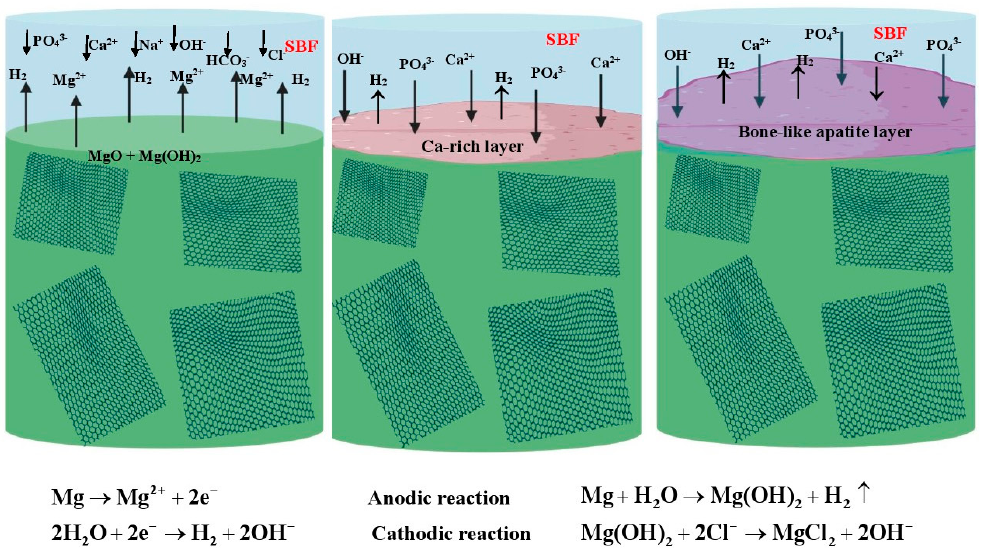
Figure 13. Schematic diagram for the corrosion product deposition on the surface of Mg-based specimens when exposed to the SBF.